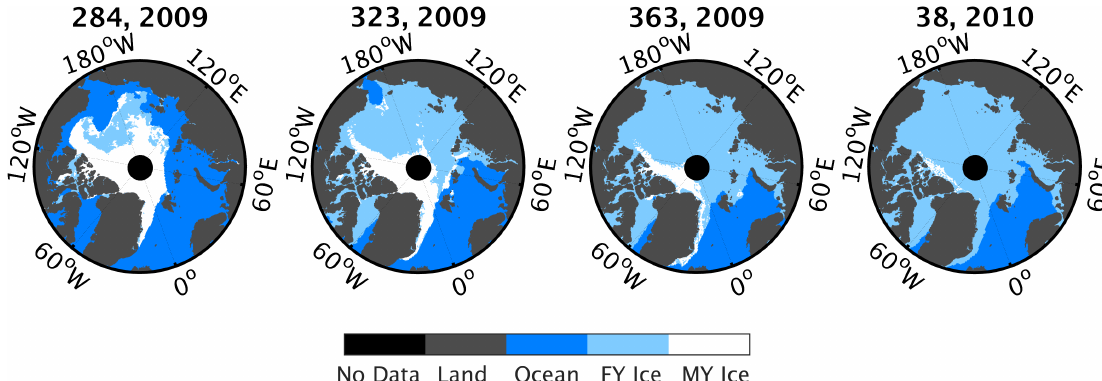
Figure 10. Time series of ice classification images produced using ASCAT data only for the winter of 2009/2010. Images are labeled according to day of year and year. Misclassifications of ice near the ice edge result in increasing classification errors until nearly all ice is classified as